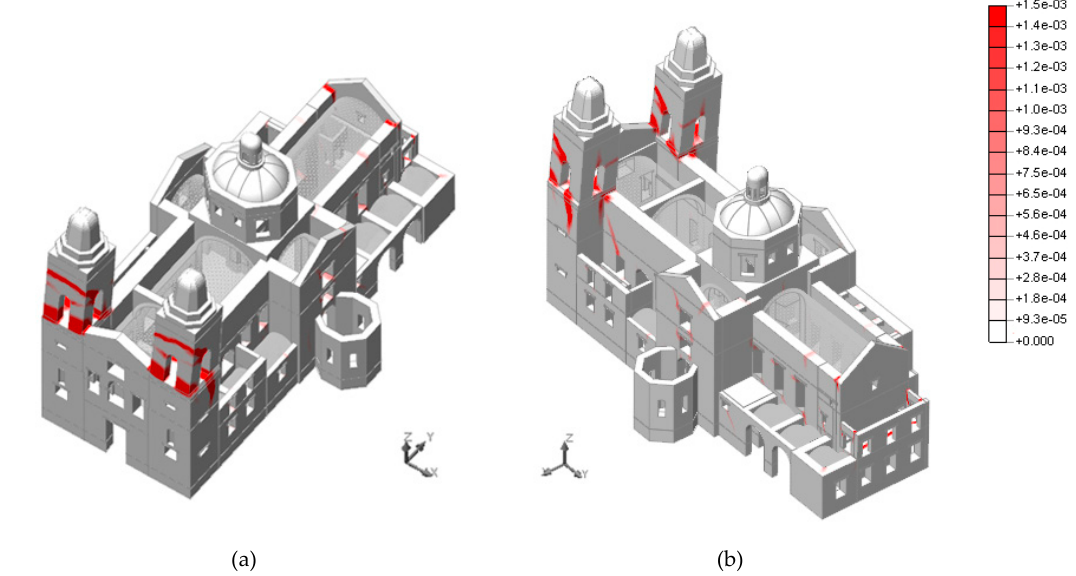
Figure 12. Crack width associated with the maximum principal strain at the end of the capacity curve for the pushover analysis in the positive longitudinal direction (+YY). ( a ) South-West view; ( b ) South-East view. Units in m.